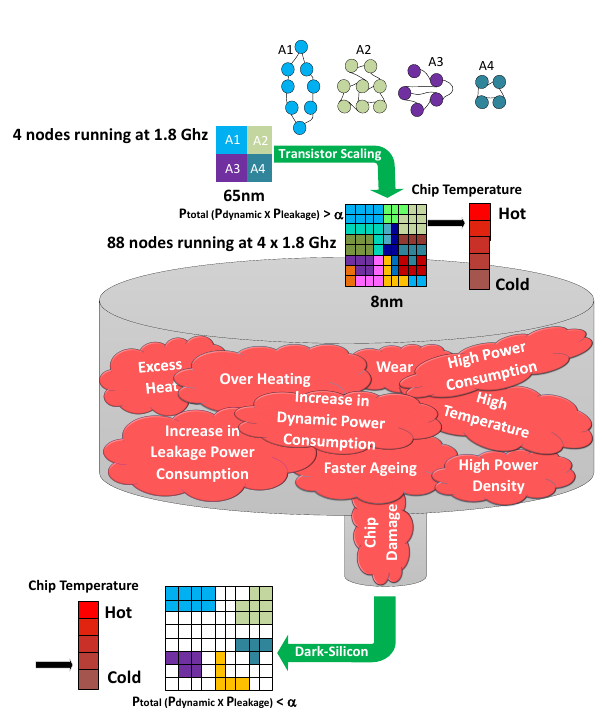
Figure 2. Effects of Transistor